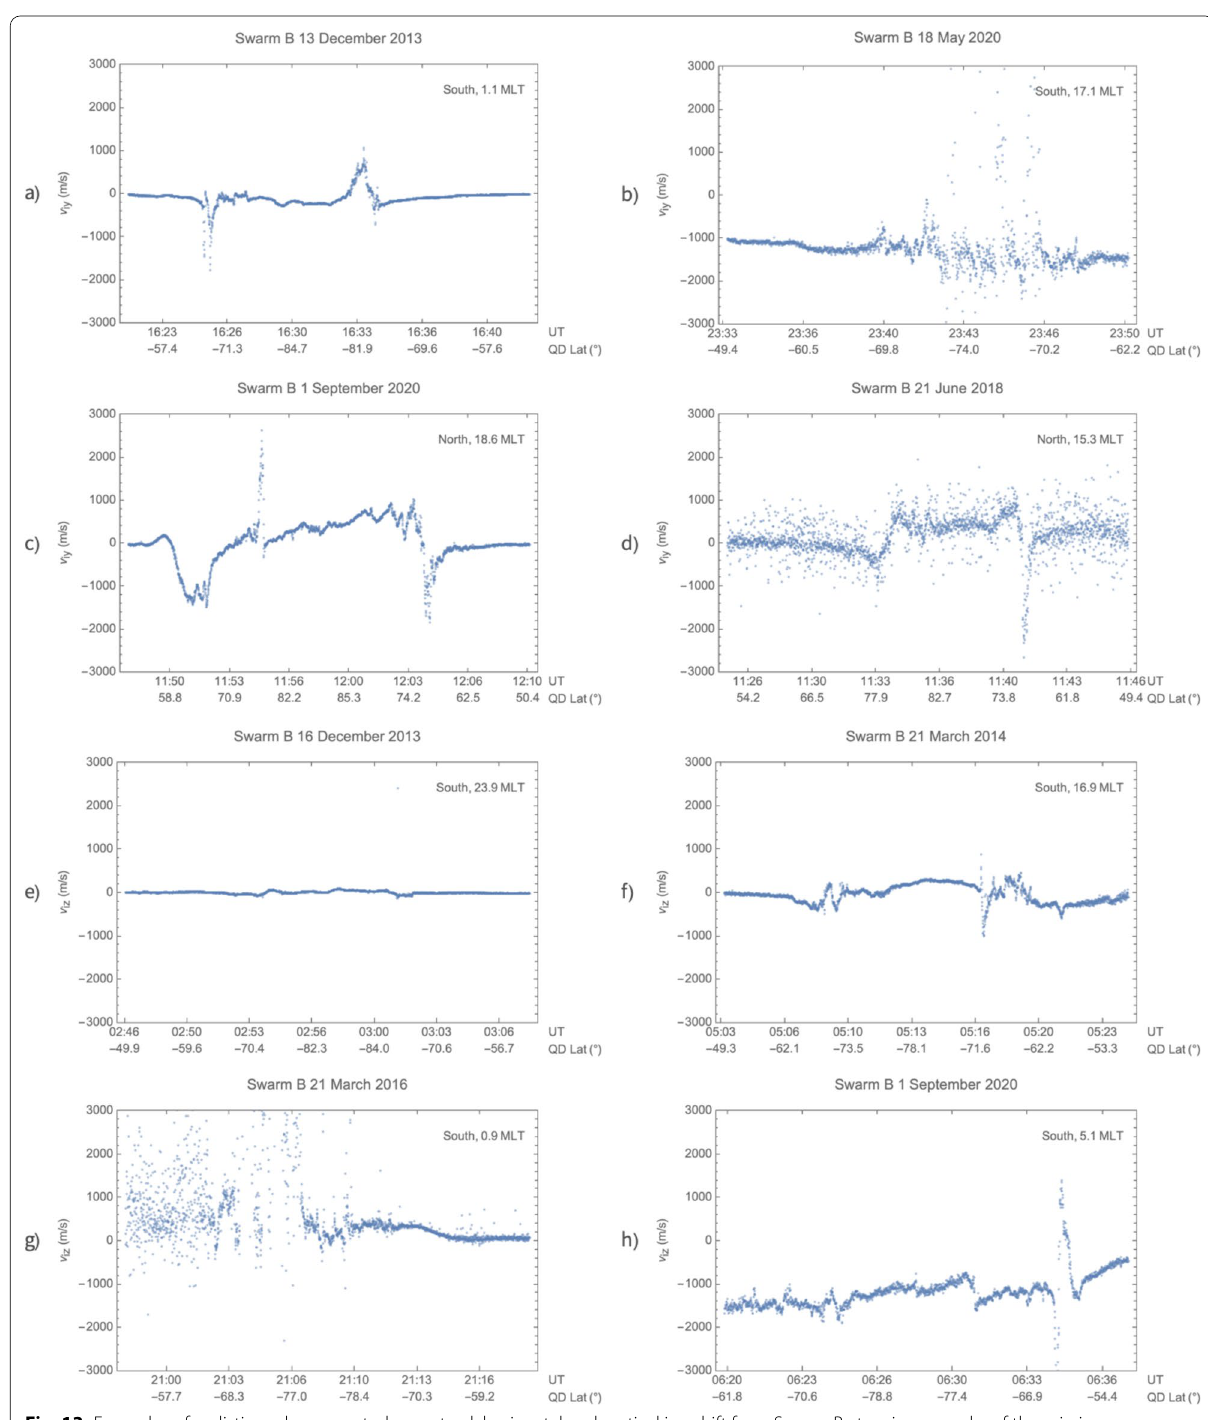
Fig. 13 Examples of realistic and unexpected cross-track horizontal and vertical ion drift from Swarm B at various epochs of the